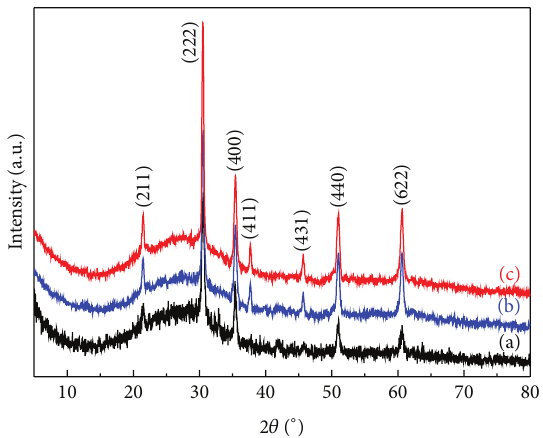
Figure1:X-raydiffractionspectraofITOthinfilmswithathickness of 199nm: (a) as-deposited, (b) annealed at 300 ∘ C, and (c) annealed at 600 ∘